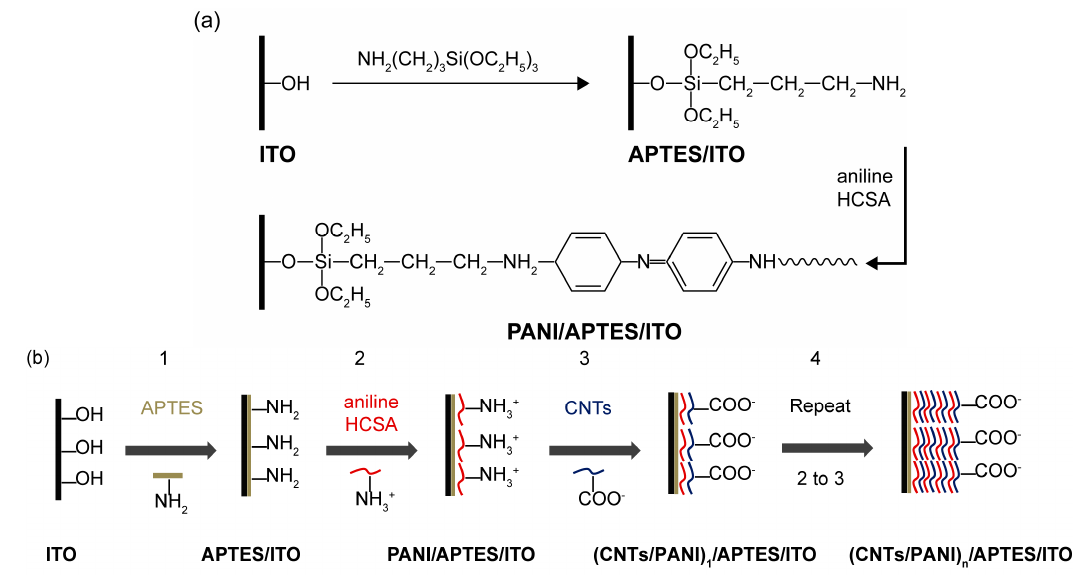
Figure 1. Mechanism of modification of PANI on ITO electrode via APTES ( a ) and schematic illustration of the fabrication process of (CNTs/PANI) n /APTES/ITO electrode ( b ).